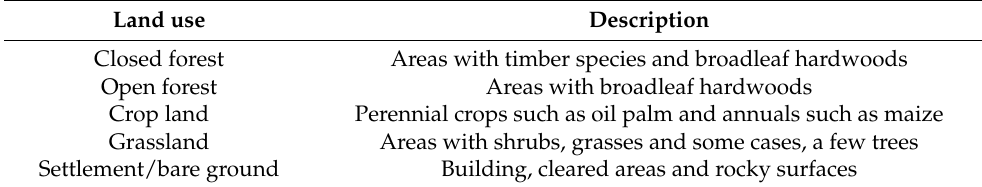
Table 3. Land use and cover classification scheme. Land use Description Closed forest Areas with timber species and broadleaf hardwoods Open forest Areas with broadleaf hardwoods Crop land Perennial crops such as oil palm and annuals such as maize Grassland Areas with shrubs, grasses and some cases, a few trees Settlement/bare